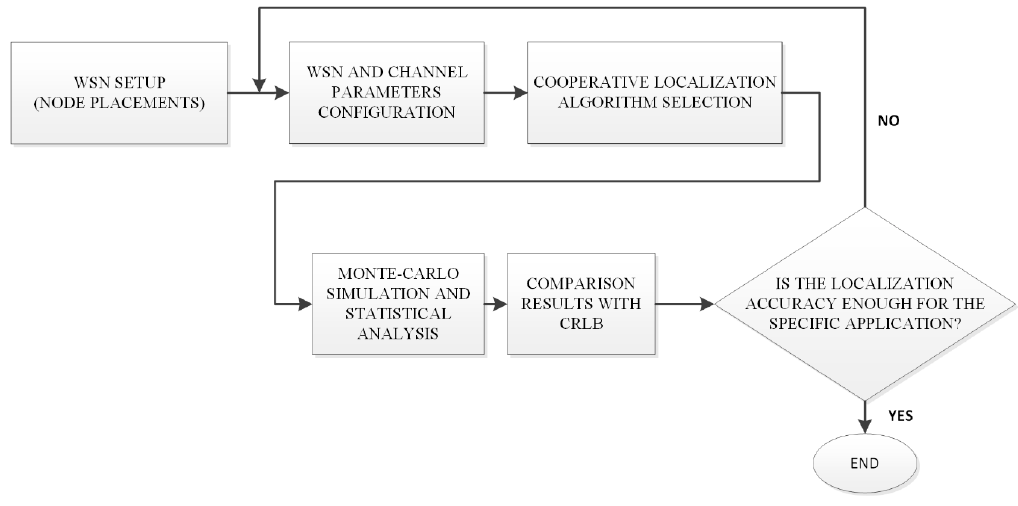
Figure 3. Workflow description of wsnLocalize.